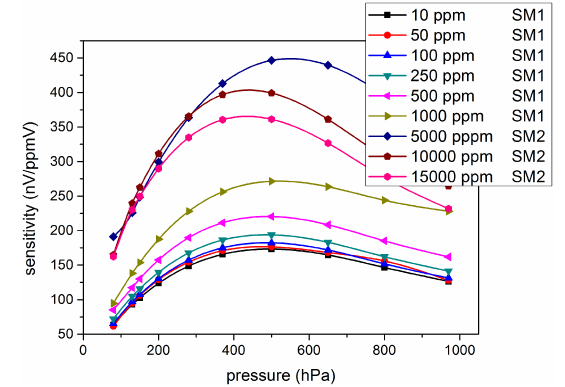
Figure 3. Calibration results at the pressure of 200hPa. Arrows rep- resent the SM switching points. Figure 4. Dependence of the sensitivity of the PA system as the function of pressure at various VMRs. The sensitivities correspond- ing to 5000, 10000 and 15000ppmV were measured at SM2 and up-scaled with a factor of 10 for better comparability, while the other curves were measured at